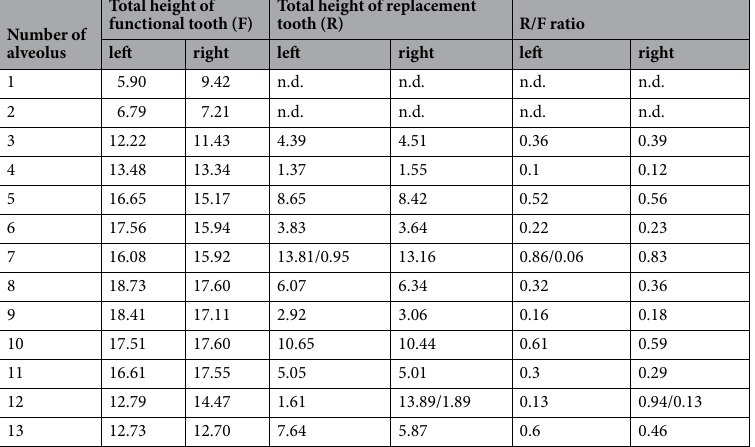
Table 2. Tooth height and the R/F ratio in the upper jaws of IVPP V12738. n.d. = not developed. All measurements in